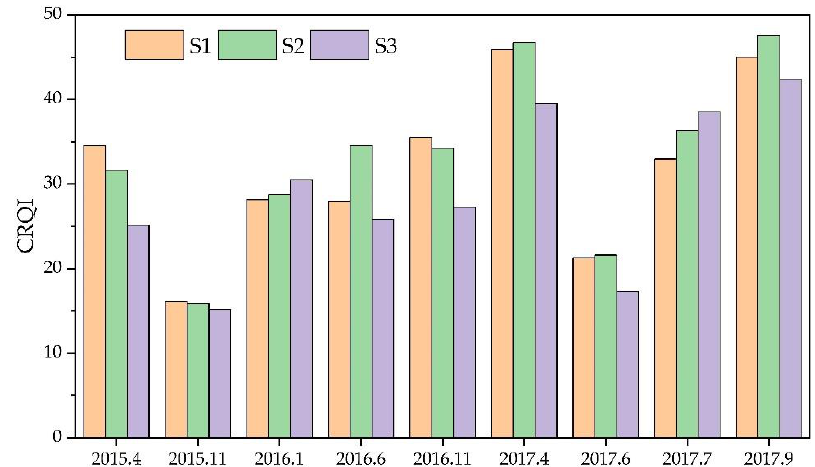
Figure 8. Cyanophyte relative quantity index from 2015–2017 in Lake Yangzong. Note: The ordinate value in the figure was calculated using the formula CRQI = [PC]/[Chl- a ], and its unit is cells/μg.